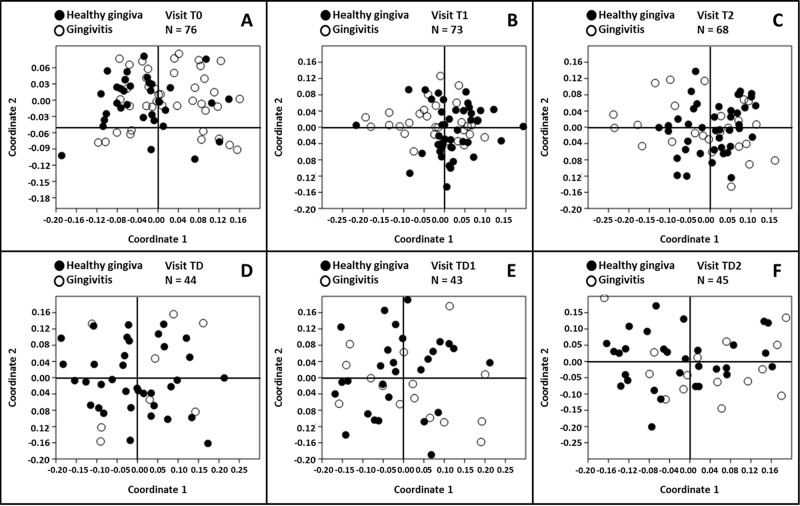
Non-metric multidimensional scaling plots based on the three-dimensional Bray-Curtis similarity index by gingival health status.The plots are constructed per visit. The subjects with healthy gingiva are indicated with ○, the subjects with gingivitis are indicated with ●. Stress for the individual plots is (A) 0.1539, (B) 0.1474, (C) 0.1265, (D) 0.1401, (E) 0.1495 and (F) 0.1531.